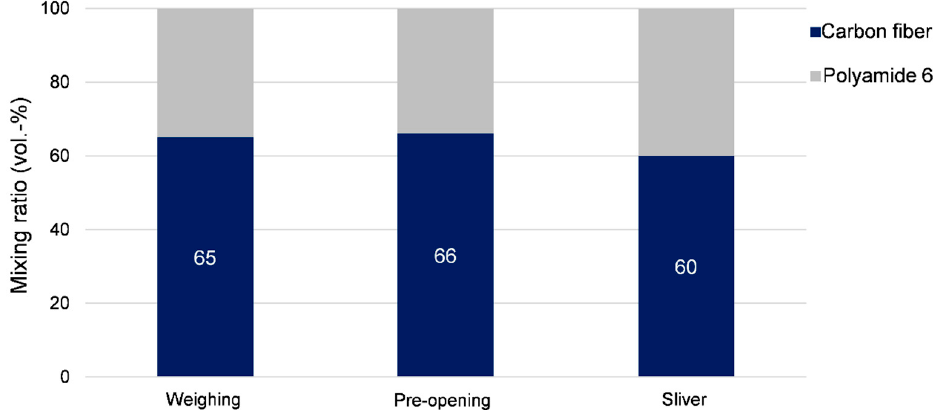
Figure 8. Change of the mixing ratio over the sliver production process.